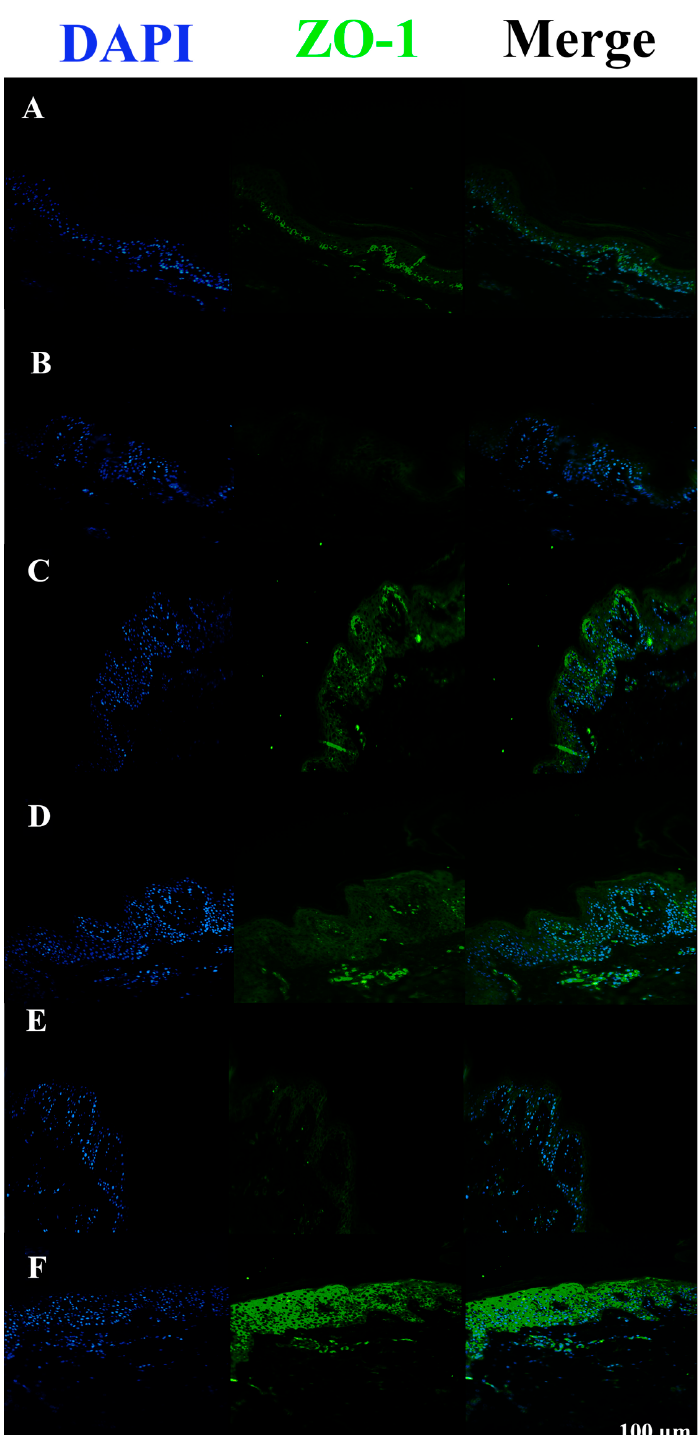
Figure 9. ZO-1 immunofluorescence on animal explant sections infected with FCS processing (20 × magnification). DAPI (461 nm, blue) is shown on the left side; Anti-ZO-1 antibody Alexa488 nm- conjugated is shown in the middle; merge images are shown on the right. Lane description. ( A ) Not infected tissues; ( B ) not treated infected tissues; ( C ) c40 pre-incubated infected tissues; ( D ) HAc40 pre-incubated infected tissues; ( E ) c40 co-incubated infected tissues; ( F ): HAc40 co-incubated infected tissues. The ZO-1 (FITC) signal in Hac40 pre-incubated and c40 co-incubated tissues was almost comparable to the untreated control. Scale bar 100 µ